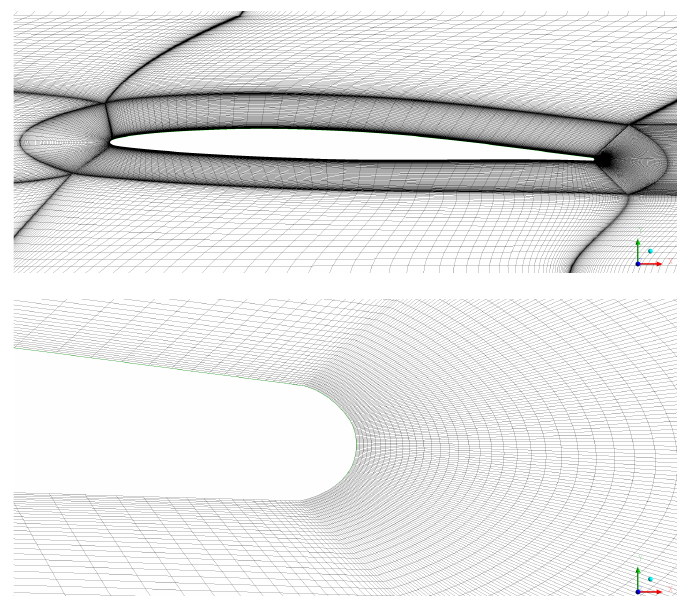
Figure 2. Detail of the computational grid around one blade ( top ), and blowing up on the trailing edge area ( bottom